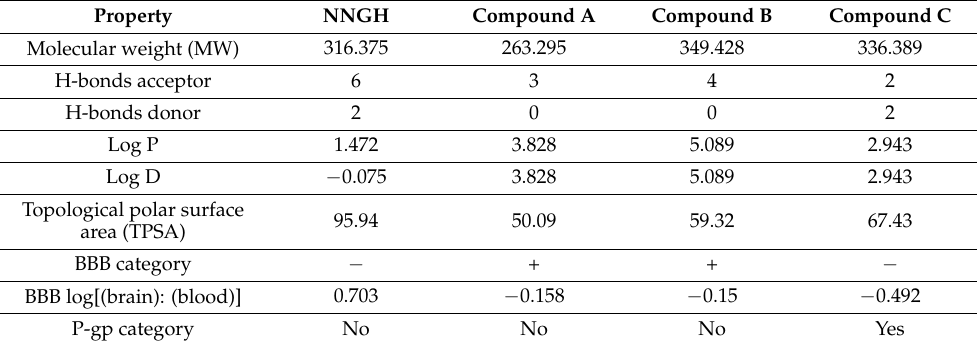
Table 2. Physicochemical and ADMET properties of the NNGH inhibitor and the compounds A, B and